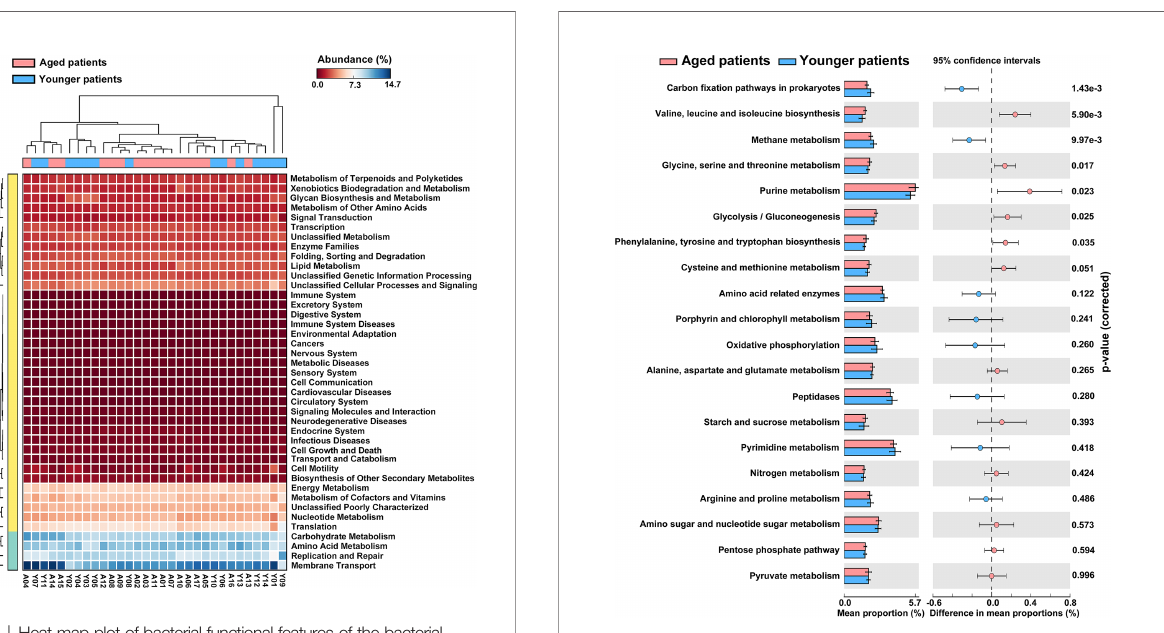
FIGURE 7 | Differences in abundance of the thirdly bacterial metabolic pathways (the top 20 enriched) between aged and younger